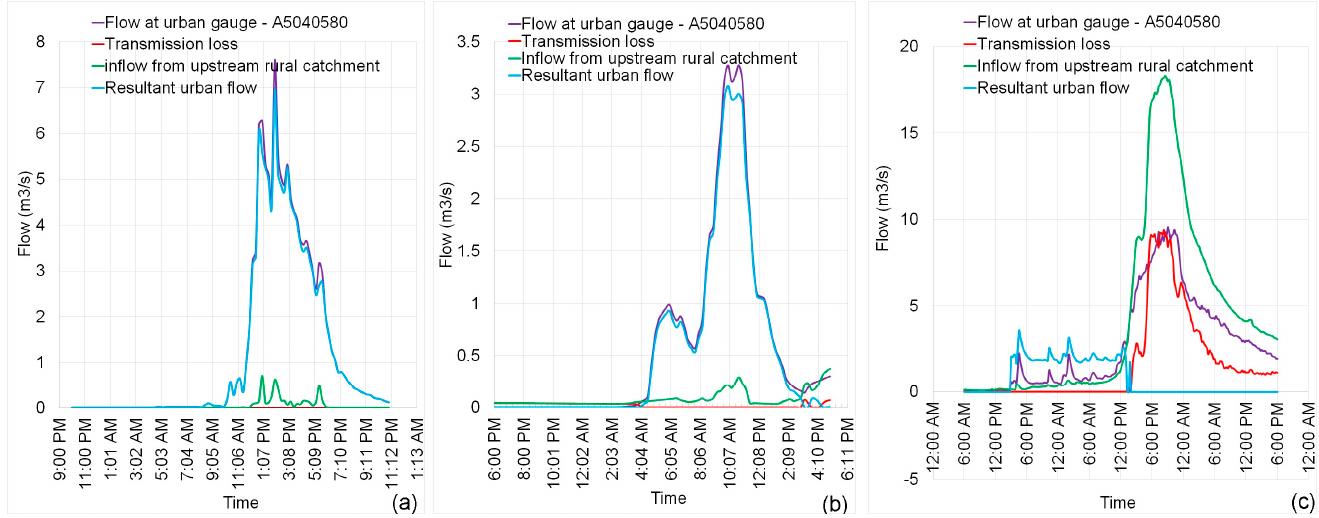
Figure 7. Urban flow based on event ( a ) U17 ( b ) U1 ( c ) 13/09/2016 .